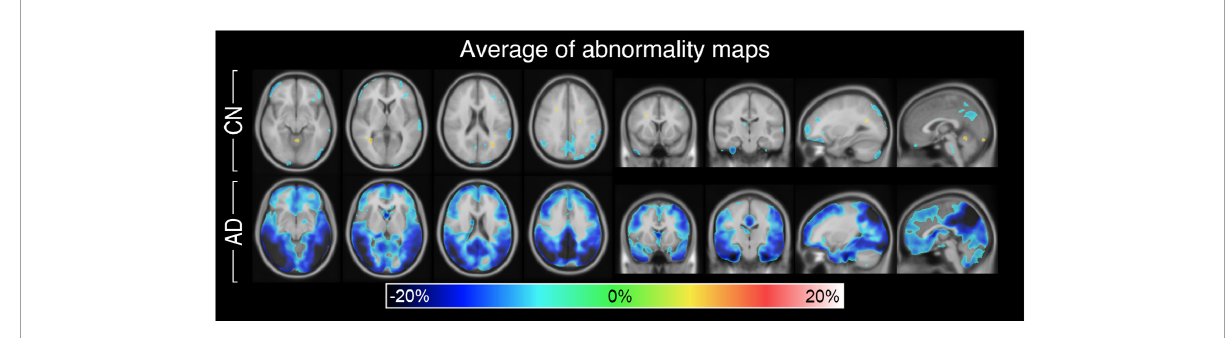
FIGURE5 Abnormality maps of the CN group ( n = 9) and AD group ( n = 10) nonlinearly registered to MNI space and averaged. On average, the personalized method finds little to no abnormality for the CN group but significant hypometabolism in the gray matter of the AD group.